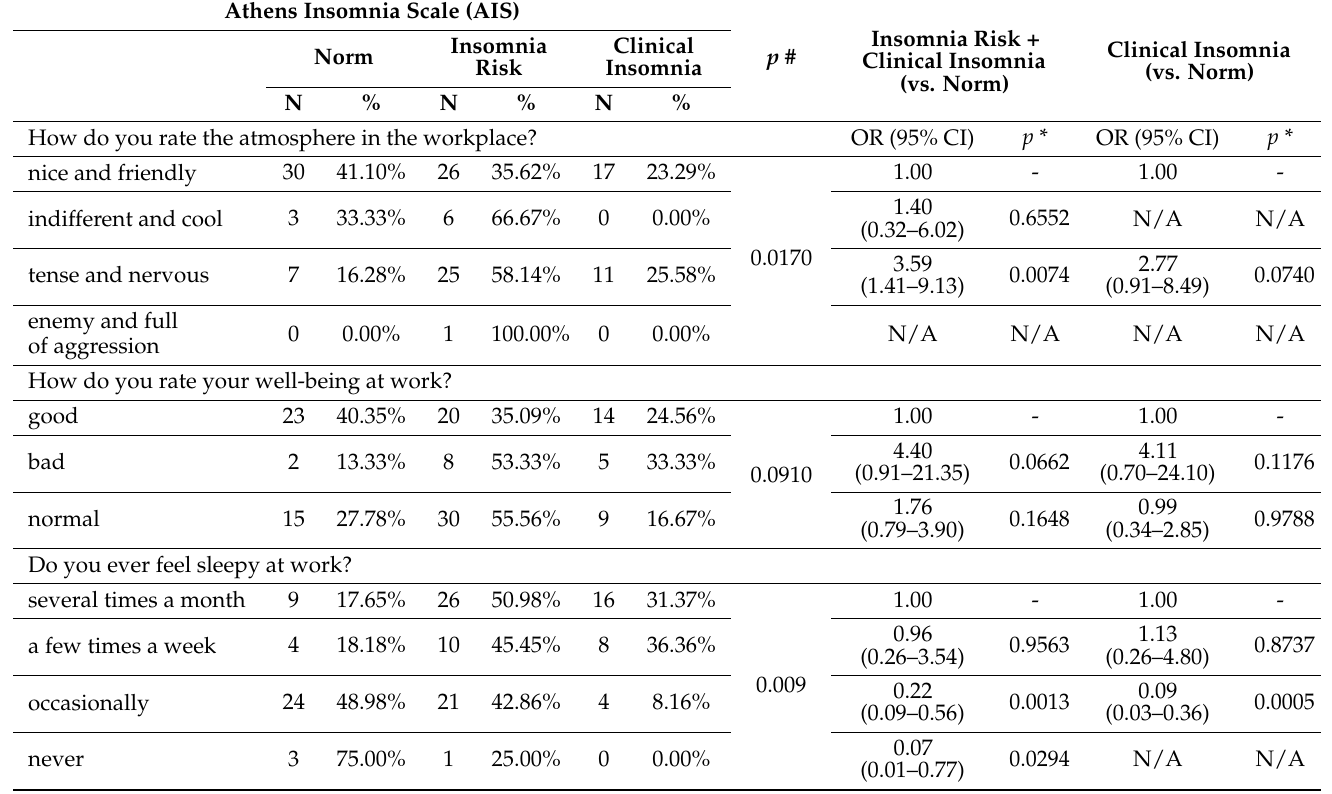
Table 2. Atmosphere in the workplace, assessment of well-being and the phenomenon of fatigue at